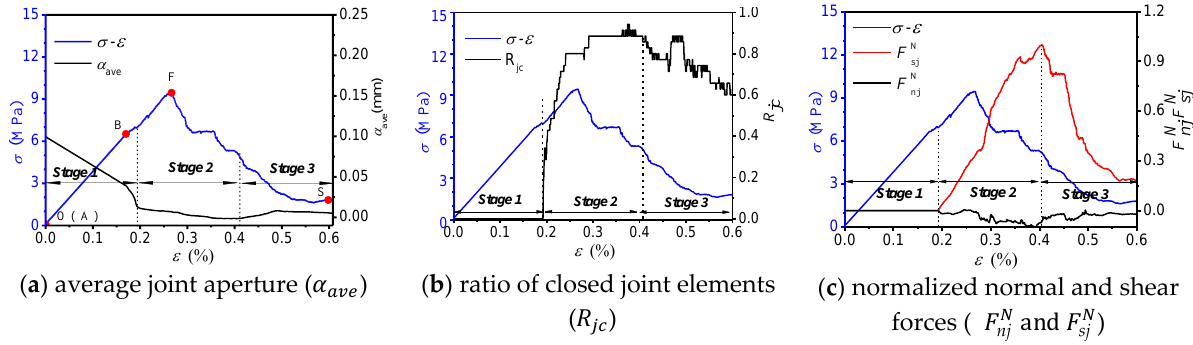
Figure 9. Evolution of the parameters of the joint system with increasing axial strain ( β = 0 ◦ ).